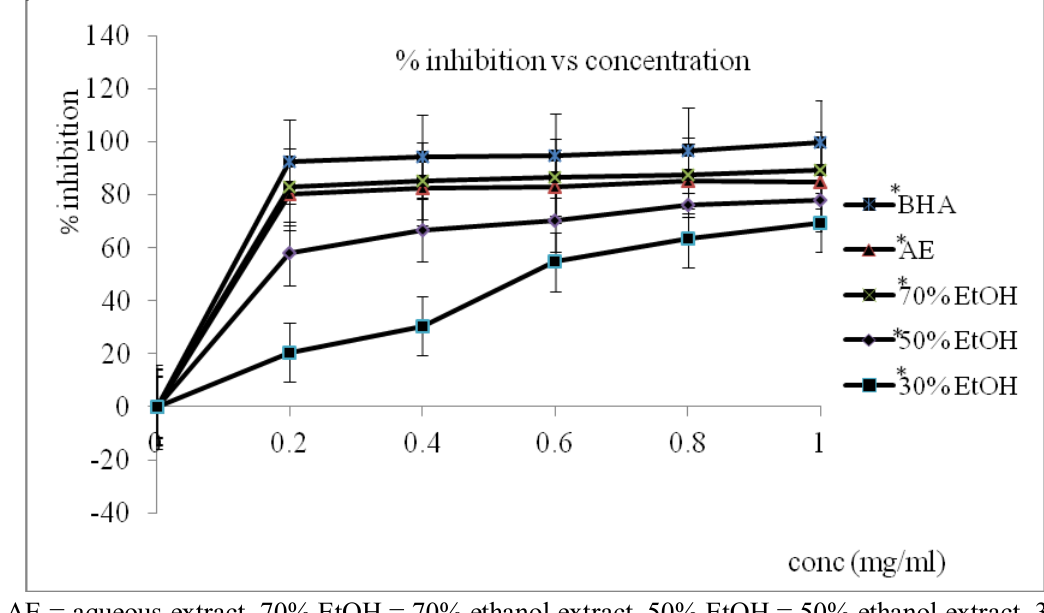
Figure 2. DPPH free radical scavenging activity (%) of the aqueous and ethanol S. asper freeze dried leaves extract and BHA. Mean ± standard deviation ( n = 3).